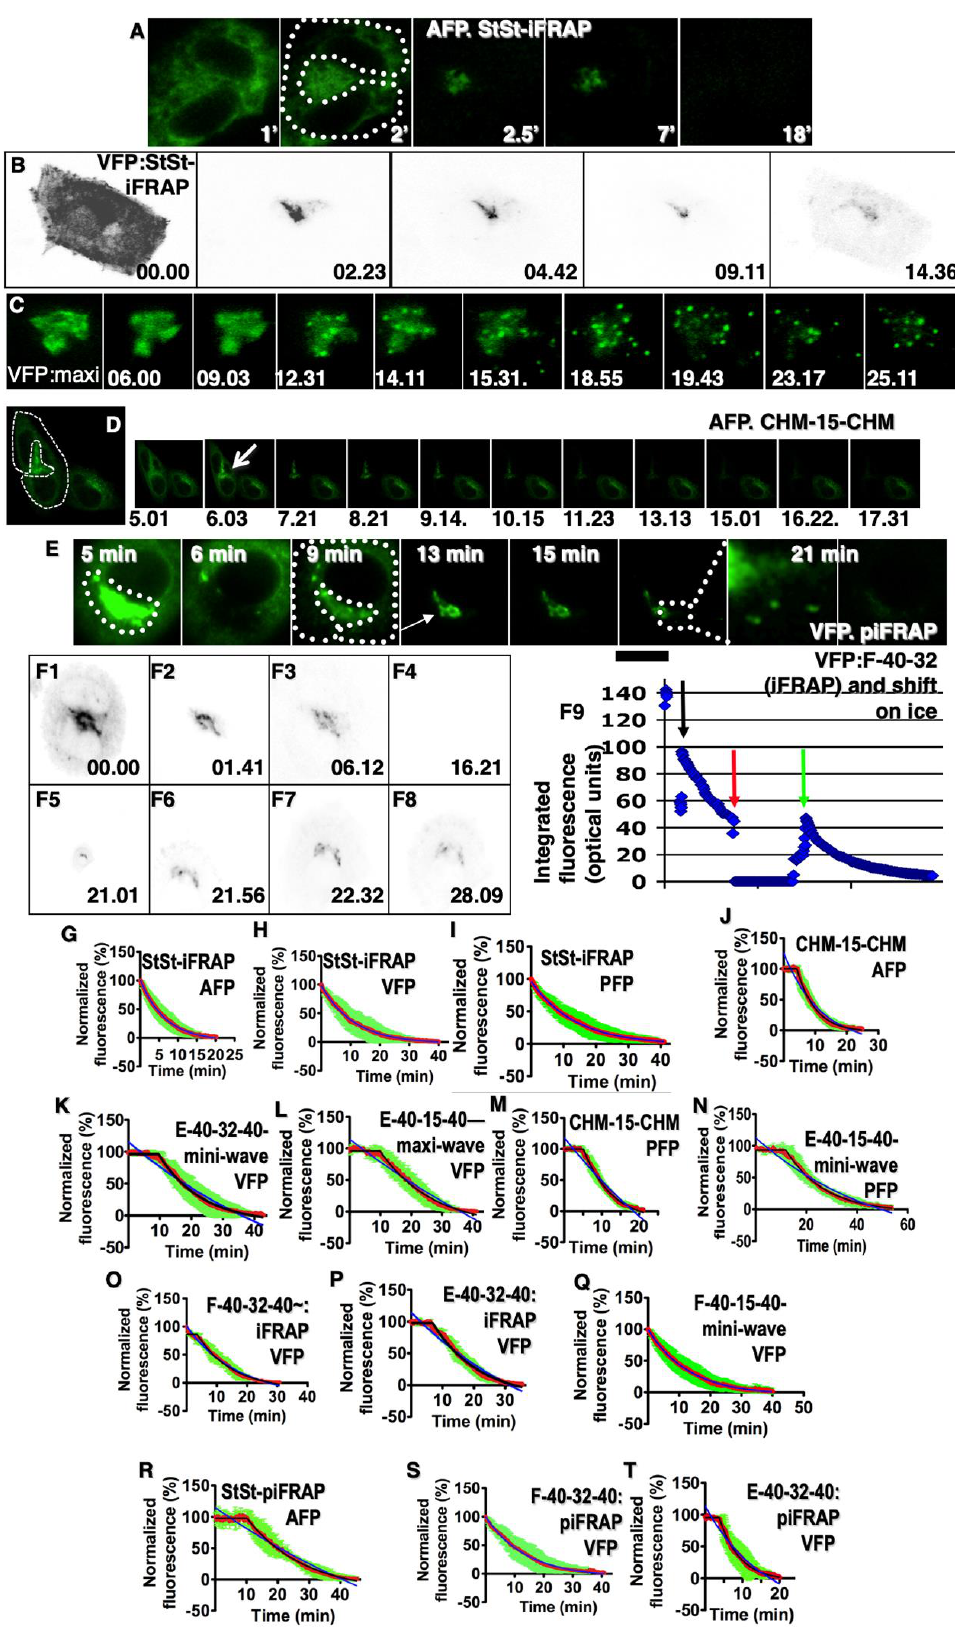
Figure 4. Kinetics of the cargo exit from the Golgi zone. Cells were subjected to bleaching and